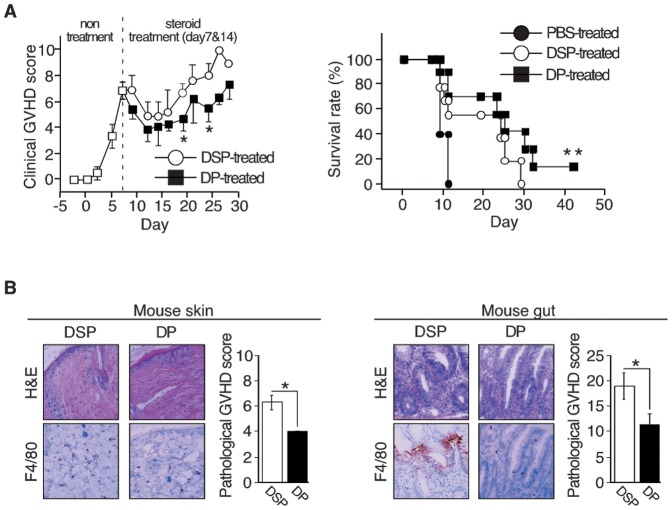
Effect of dexamethasone palmitate on macrophages in mice with fatal GVHD.
A: Clinical assessment of GVHD after DP or DSP treatment. Mice were treated with DP or DSP (10 mg/kg/each day) on day 7 and day14 after co-transplantation of TCD-BM and spleen-derived T lymphocytes (control: n = 9, DSP: n = 9, DP: n = 10). Clinical GVHD was assessed 3 times a week, using a scoring system consisting of 5 clinical parameters: weight loss, posture, activity, fur texture, and skin integrity (maximum index = 10, left panel). Statistical significance: *P<0.05 (days 19 and 24). Mortalities were counted daily for up to 42 days after transplantation (right panel). Statistical significance: **P<0.01 (PBS-treated versus DP-treated). B: Pathological assessment of GVHD after DP or DSP treatment. Skin (left panels) and gut (right panels) specimens were stained with H&E (top panels) and skin macrophages were detected with the anti-mouse F4/80 monoclonal antibody (bottom panels). Original magnification, ×400. Representative images of the skin of three mice are shown. Skin and gut GVHD were scored based on five parameters (epidermal damage, alteration of dermis, degree of inflammation, alteration of subcutaneous fat and number of follicles) and seven parameters (crypt regeneration, crypt epithelial cell apoptosis, crypt loss, surface colonocyte vacuolization, surface colonocyte attenuation, lamina propria inflammatory cell infiltrate and mucosal ulceration), respectively, and are presented as histograms. Statistical significance: *P<0.05.